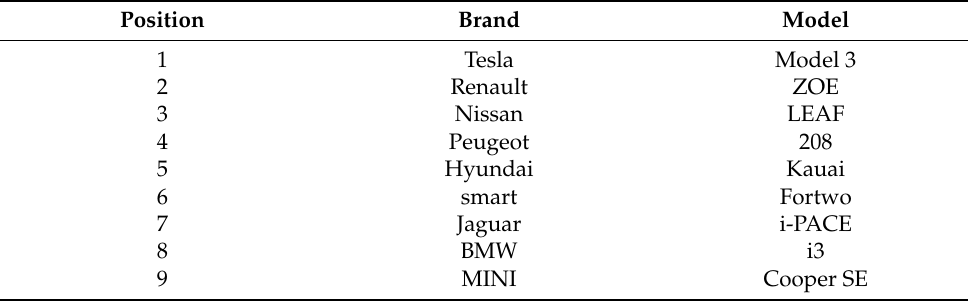
Table 5. The twelve most registered brands in Portugal, first 8 months of 2020 [25]. Position